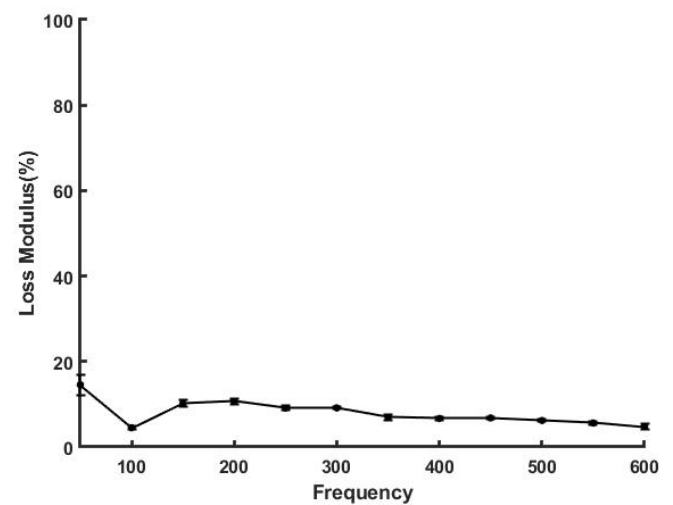
Figure 5. Loss modulus as a % of the elastic modulus for decellularized human dermis in vitro. Note the loss modulus is 12% at low frequencies and drops to about 3% at the resonant frequency.